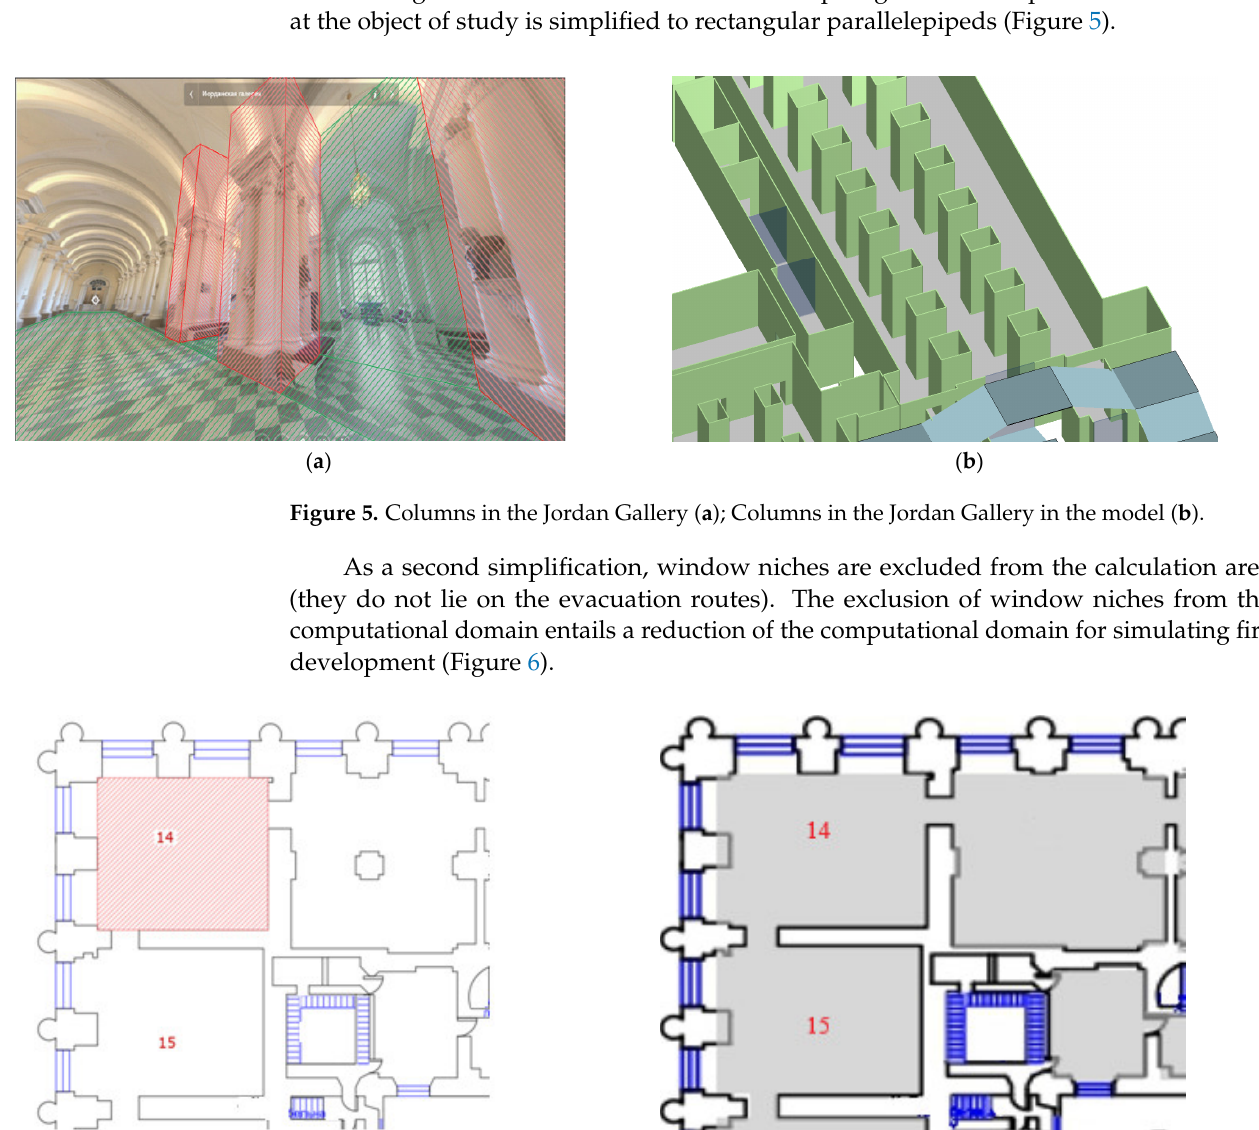
Figure 6. Bronze Age Hall on the plan of the Winter Palace ( a ); in the model ( b